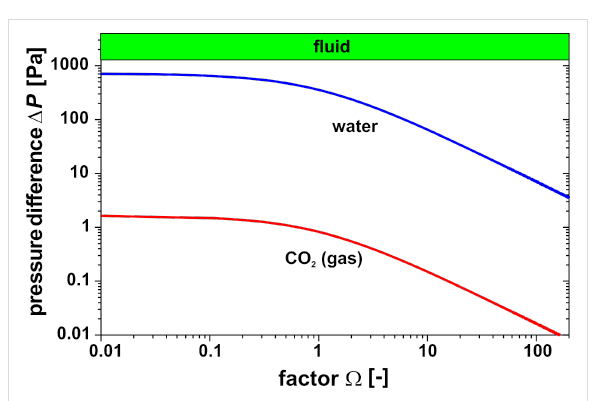
Figure 9: Pressure difference Δ P of a circular membrane at t = 0.5 s as a function of factor Ω for a water-filled and CO 2 -filled cavity. IR power density 10 W/m 2 , diameter and height of the cavity: 0.5